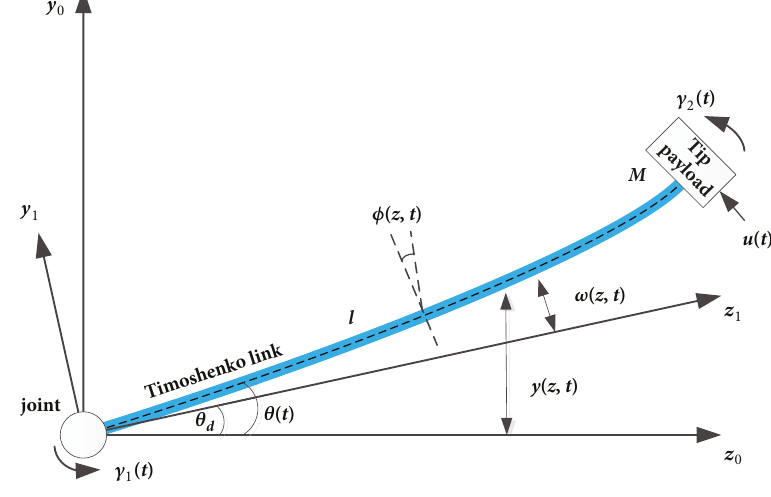
Figure 1: Flexible Timoshenko